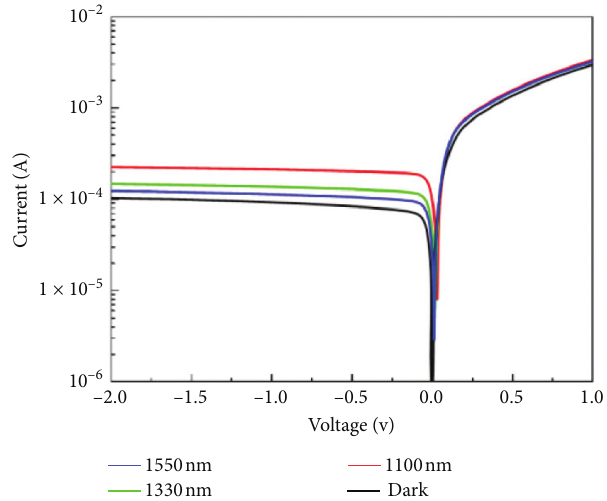
Figure 5: Dark and photo I–V curves under illumination of different